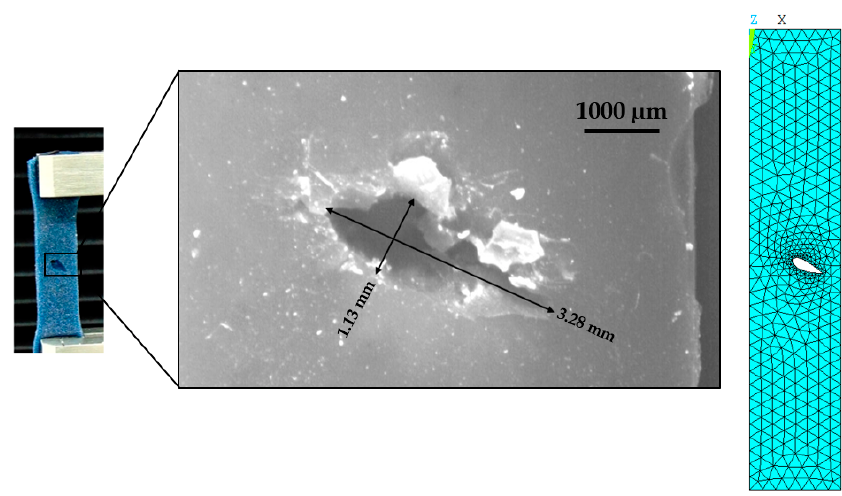
Figure 5. Coupon with transverse wound dimensions observed under a microscope and finite element (FE) model of the coupon with the wound.